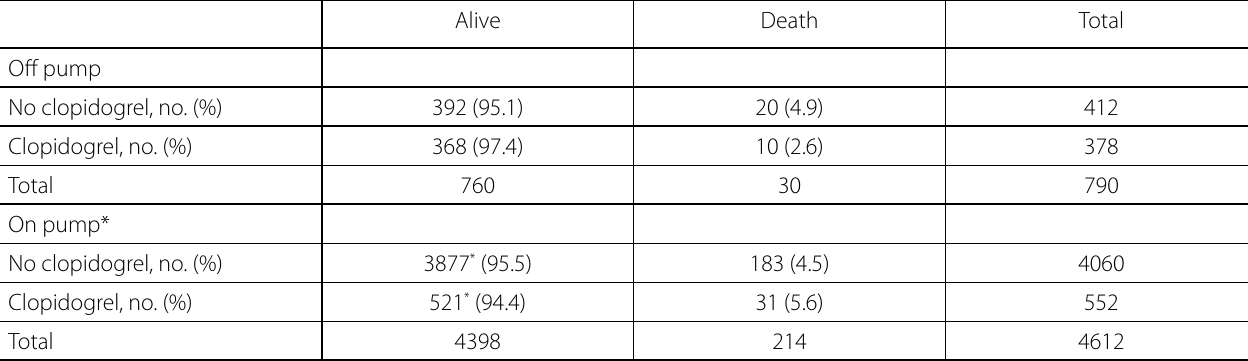
*One on-pump patient without and one on-pump patient with clopidogrel after CABG were censored before the 1-year